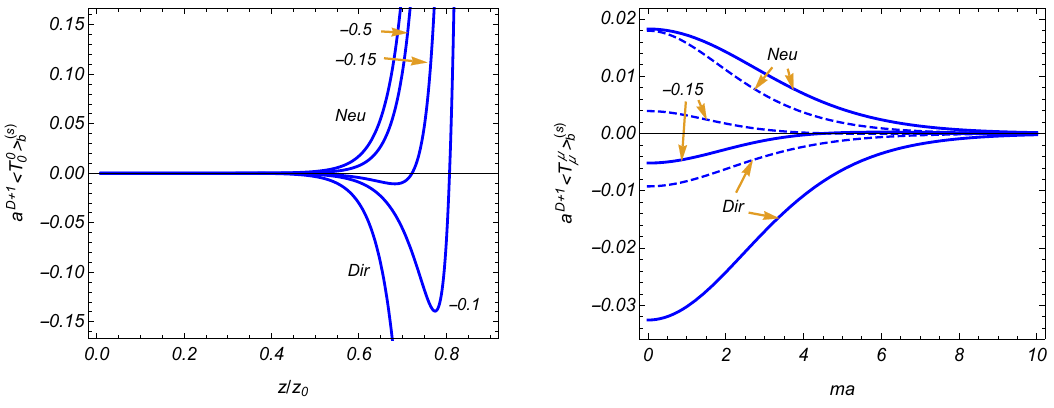
Figure 6. The same as in Figure 2 for a minimally coupled scalar field in the L-region. The left and right panels are plotted for ma = 1 and z / z 0 = 0.6,